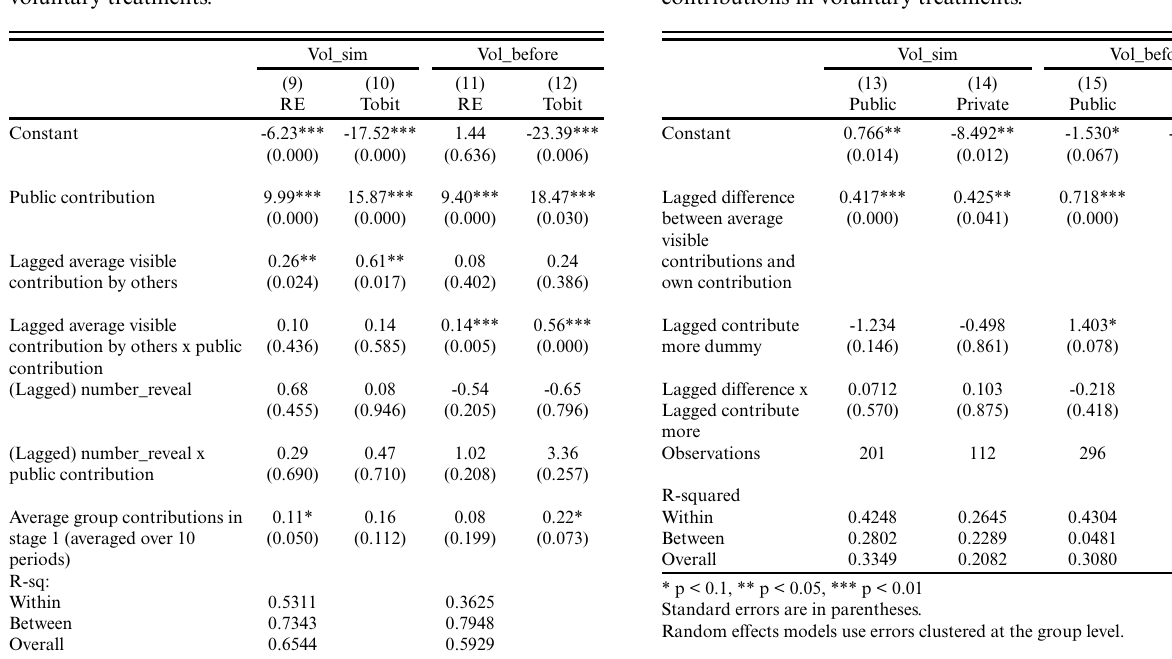
Table 6 . Regression analyses of individual level contributions in voluntary treatments.